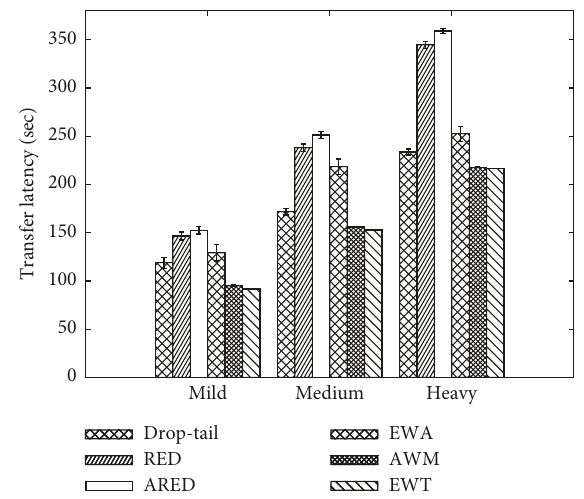
Figure 6: File transfer latency: Scenario 1.